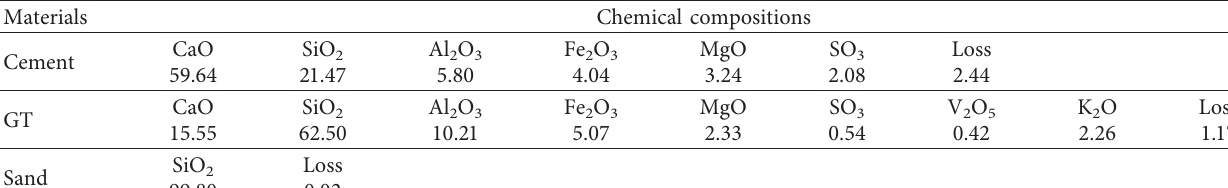
Table 2: Chemical properties of Portland cement, sand, and graphite tailings (%).